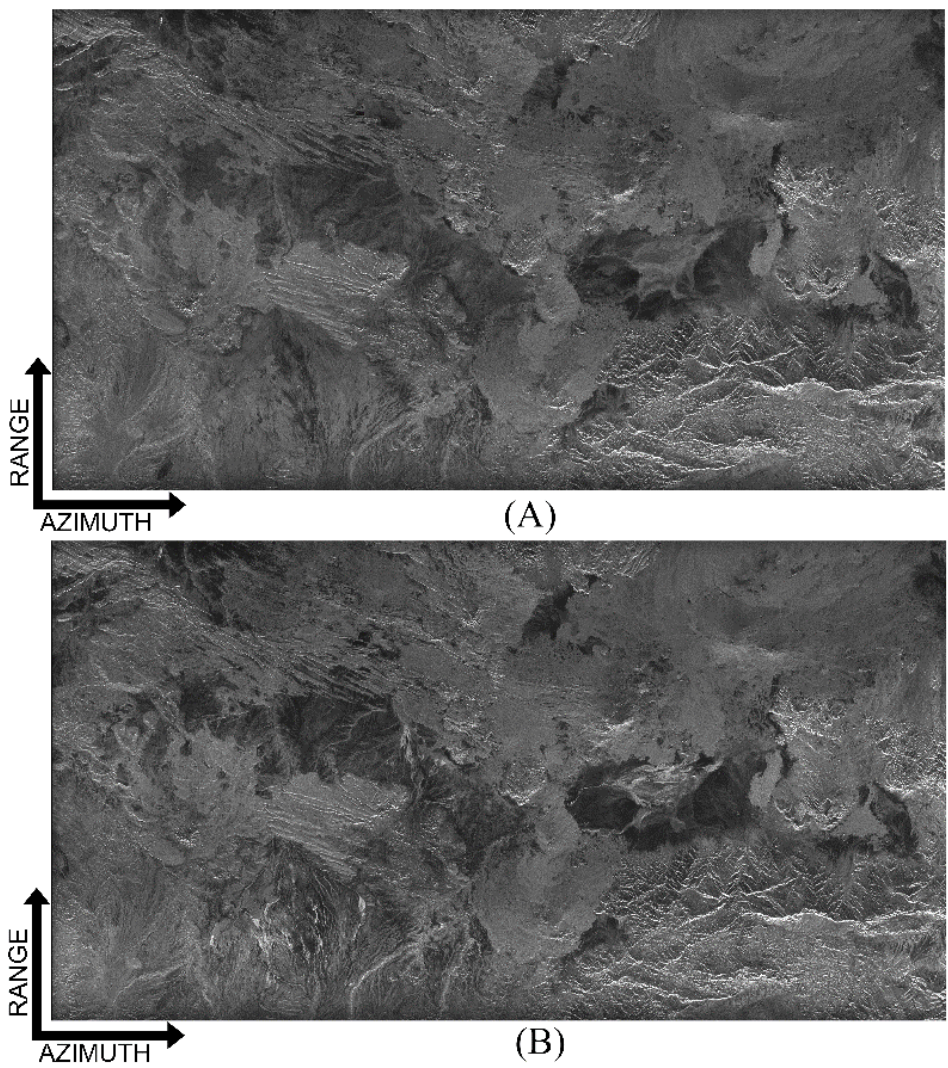
Figure 9. Afar depression region. Amplitude SAR images of the ASAR master ( A ) and slave ( B ) acquisitions, collected on 19 December 2005 and 25 August 2008, respectively.